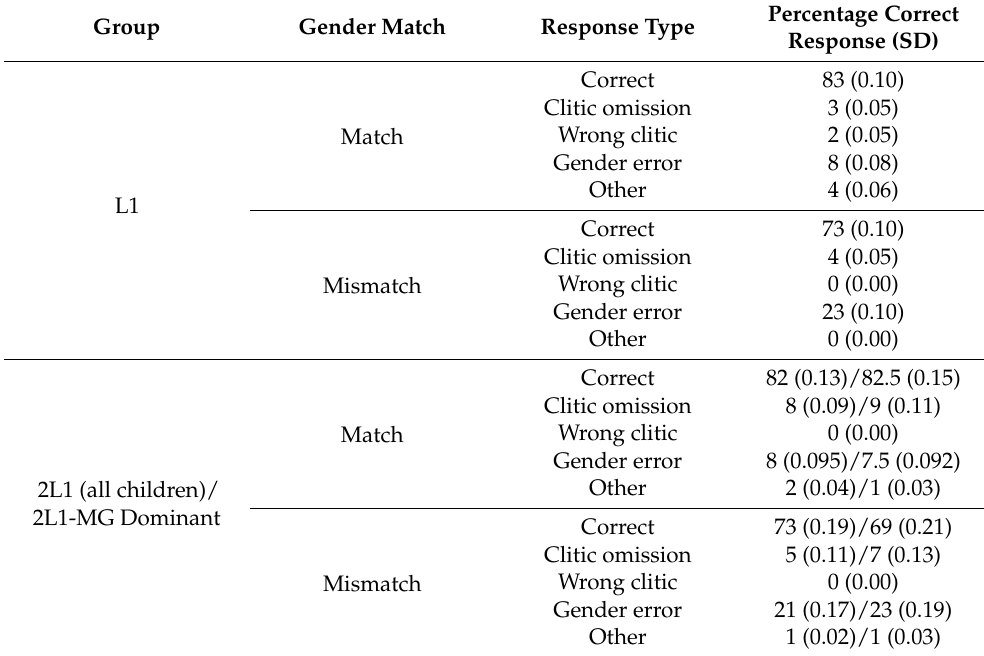
Table 8. Mean percentage and standard deviation of all response types for each group in